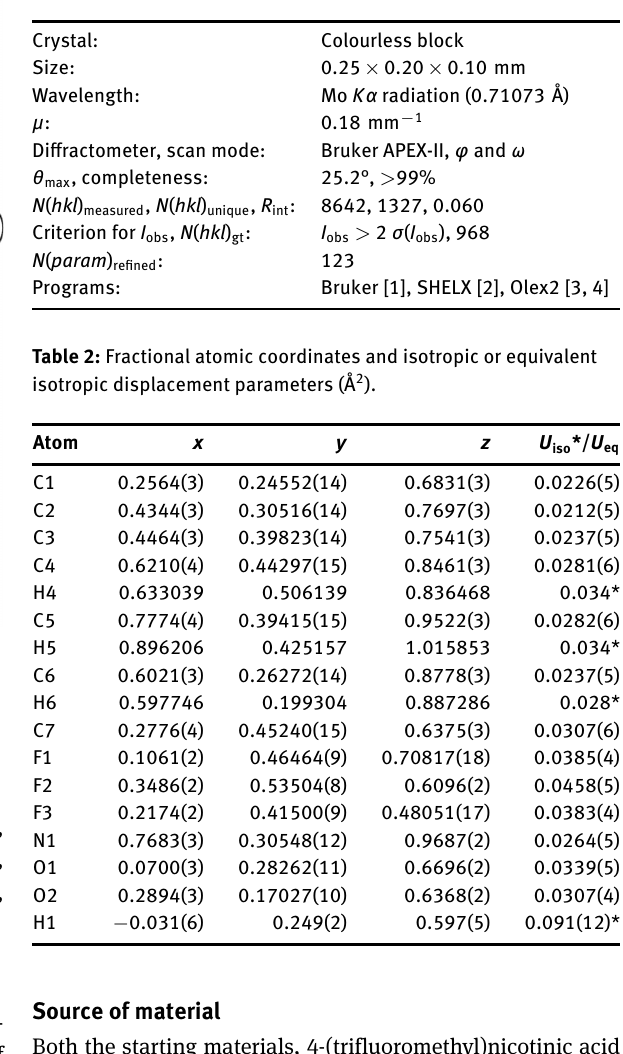
Table 1: Data collection and handling.